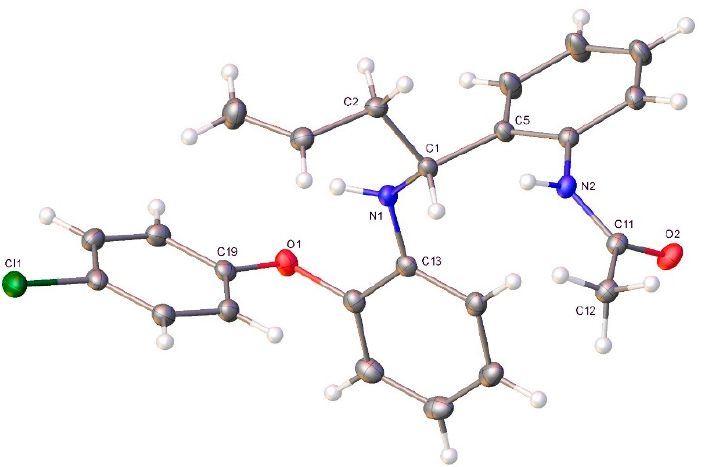
Figure 9. X-ray crystal structure of enantiomer A ( 31 , ( R )-). Inactive. Ellipsoids are represented at 30% probability.